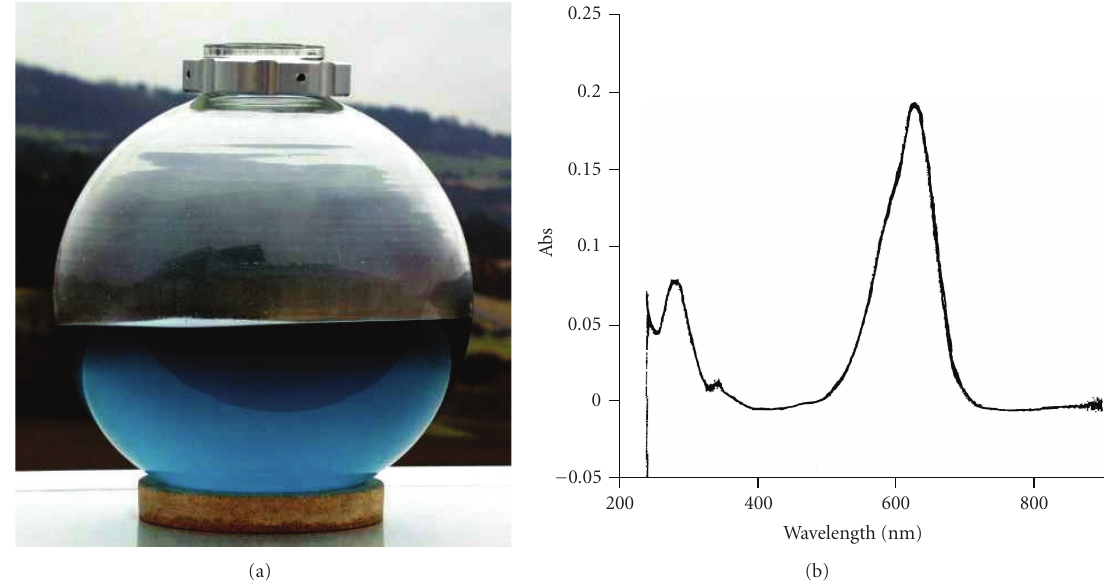
Figure 2: Glaukothalin isolated from Rheinheimera sp. strain HP1 grown in a 50 L fermenter on Marine Broth (MB2216) medium: (a) blue color, (b) UV spectrum in CHCl 3 .